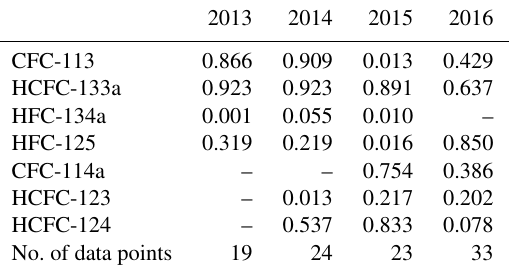
Table 2. Squared Pearson correlations ( R 2 ) of CFC-113a mixing ratios with other compounds in Taiwan